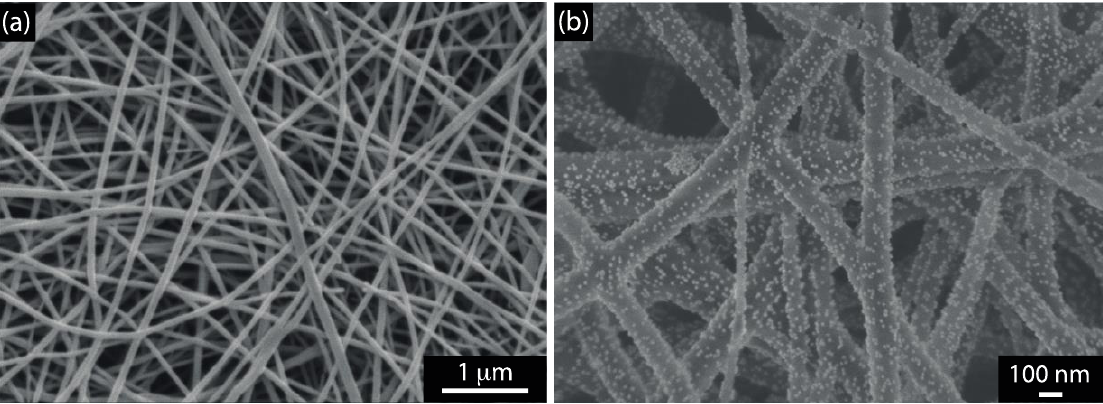
Figure 1. ( a ) SEM image of PA6/PAH and ( b ) FEG-SEM image of PA6/PAH@AuNPs nanofibers.